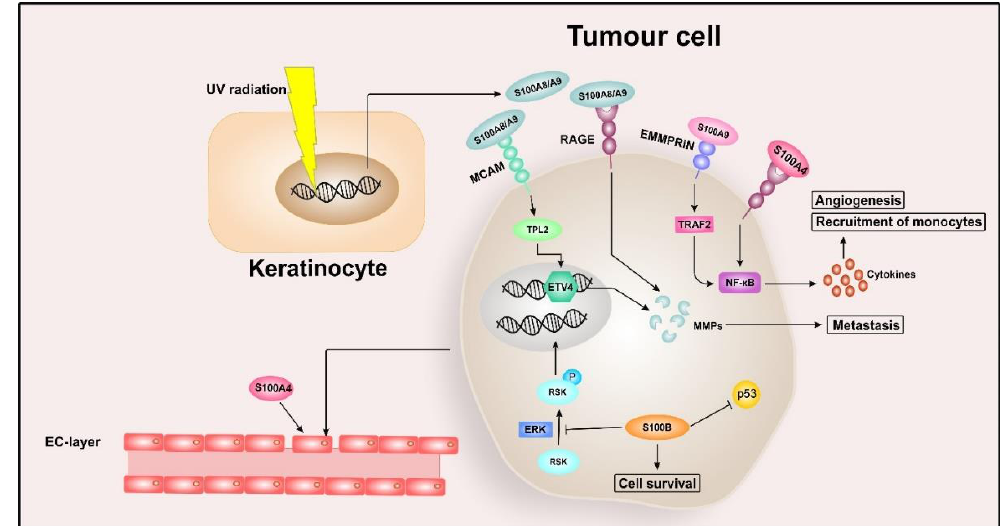
Figure 3. S100 signalling in melanoma. Extracellular S100A4 binds to the receptor for advanced glycation end products (RAGE) and thereby activates nuclear factor “kappa-light-chain-enhancer” of activated B-cells (NF-κB), resulting in the release of cytokines such as tumour necrosis factor α (TNFα). These cytokines then promote angiogenesis and recruitment of monocytes, creating an inflammatory milieu in the tumour environment. Furthermore, extracellular S100A4 also decreases the expression of occluding and vascular endothelial cadherin (VE)-cadherin in endothelial cells (ECs), thereby disrupting cell–cell adhesion and enabling the tumour cells to transmigrate through the EC monolayer into the bloodstream. The release of S100A8/S100A9 can be induced by UV radiation-exposed keratinocytes, and extracellular S100A8/S100A9 then promotes proliferation and migration of melanocytes via RAGE signalling. The interaction between S100A8/S100A9 and RAGE can lead to increased levels of the metalloproteinases MMP2, MMP9, and MMP14 in melanoma cells, thereby enhancing metastatic properties. In addition to RAGE, S100A8/A9 also binds to the melanoma cell adhesion molecule (MCAM), thereby activating tumour progression locus 2 (TPL2) and stimulating the transcription factor ETS translocation variant 4 (ETV4), leading to the induction of MMP25 and promoting melanoma lung metastasis. The homodimer of S100A9 additionally interacts with extracellular matrix metalloprotease inducer (EMMPRIN), which activates TNF receptor-associated factor (TRAF2)-dependent NF-κB signalling and the upregulation of cytokines such as TNFα, chemokine (C-X-C motif) ligand 1 (CXCL1), CXCL2, and CXCL3, resulting in metastasis. S100B inhibits the phosphorylation of ribosomal S6 kinase (RSK) by extracellular signal-regulated kinase (ERK) in a Ca 2+ -dependent manner so that RSK remains in the cytoplasm, leading to improved tumour survival. S100B also inhibits p53 activity at the protein level, thereby preventing p53-dependent apoptosis.